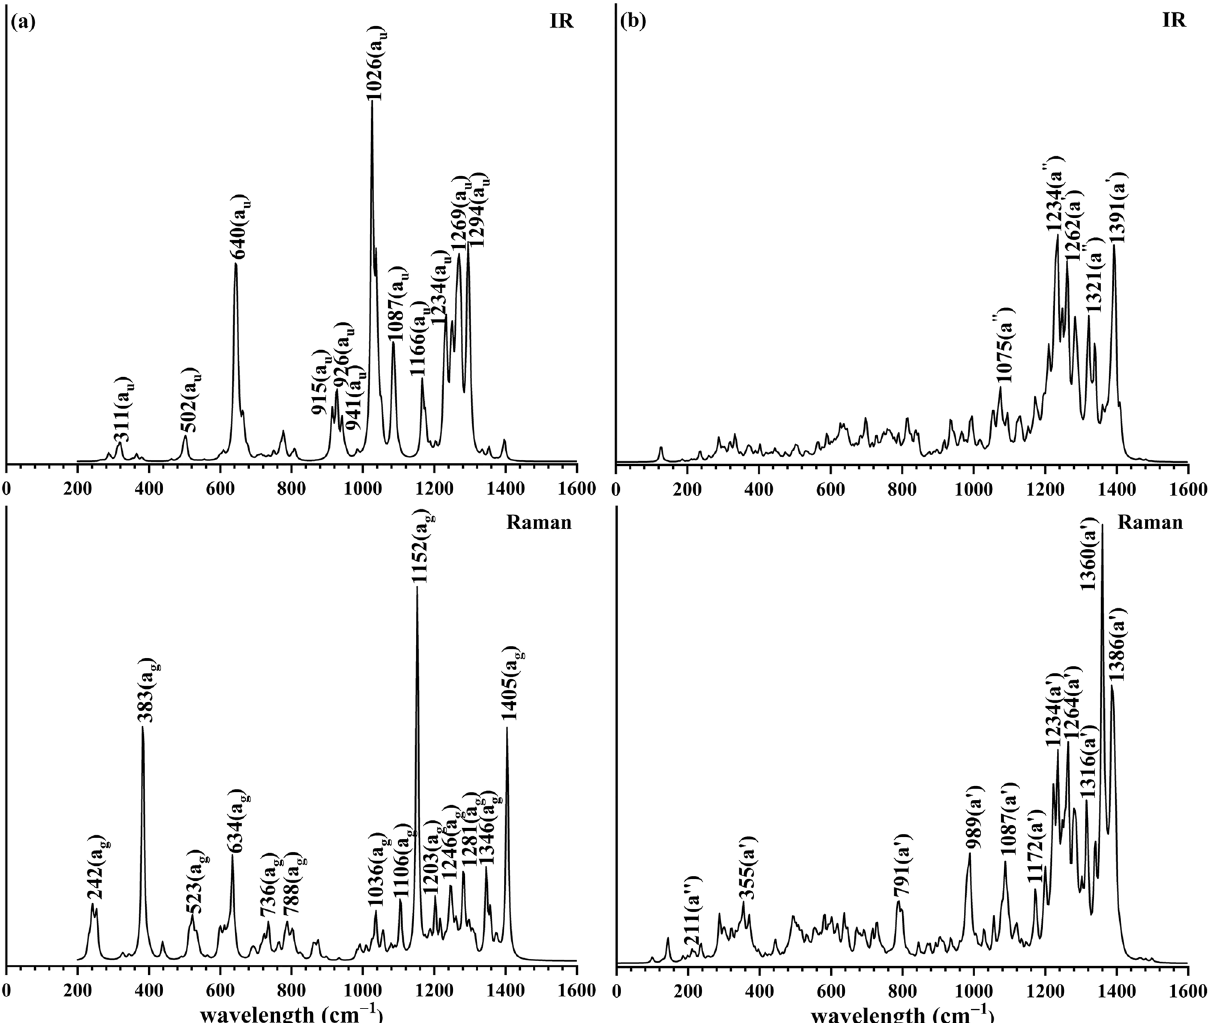
Figure 4. Simulated IR and Raman spectra of ( a ) C i C 50 B 54 ( 1 ) and ( b ) C s C 88 B 78 (4 ) at PBE0/6-31G(d)